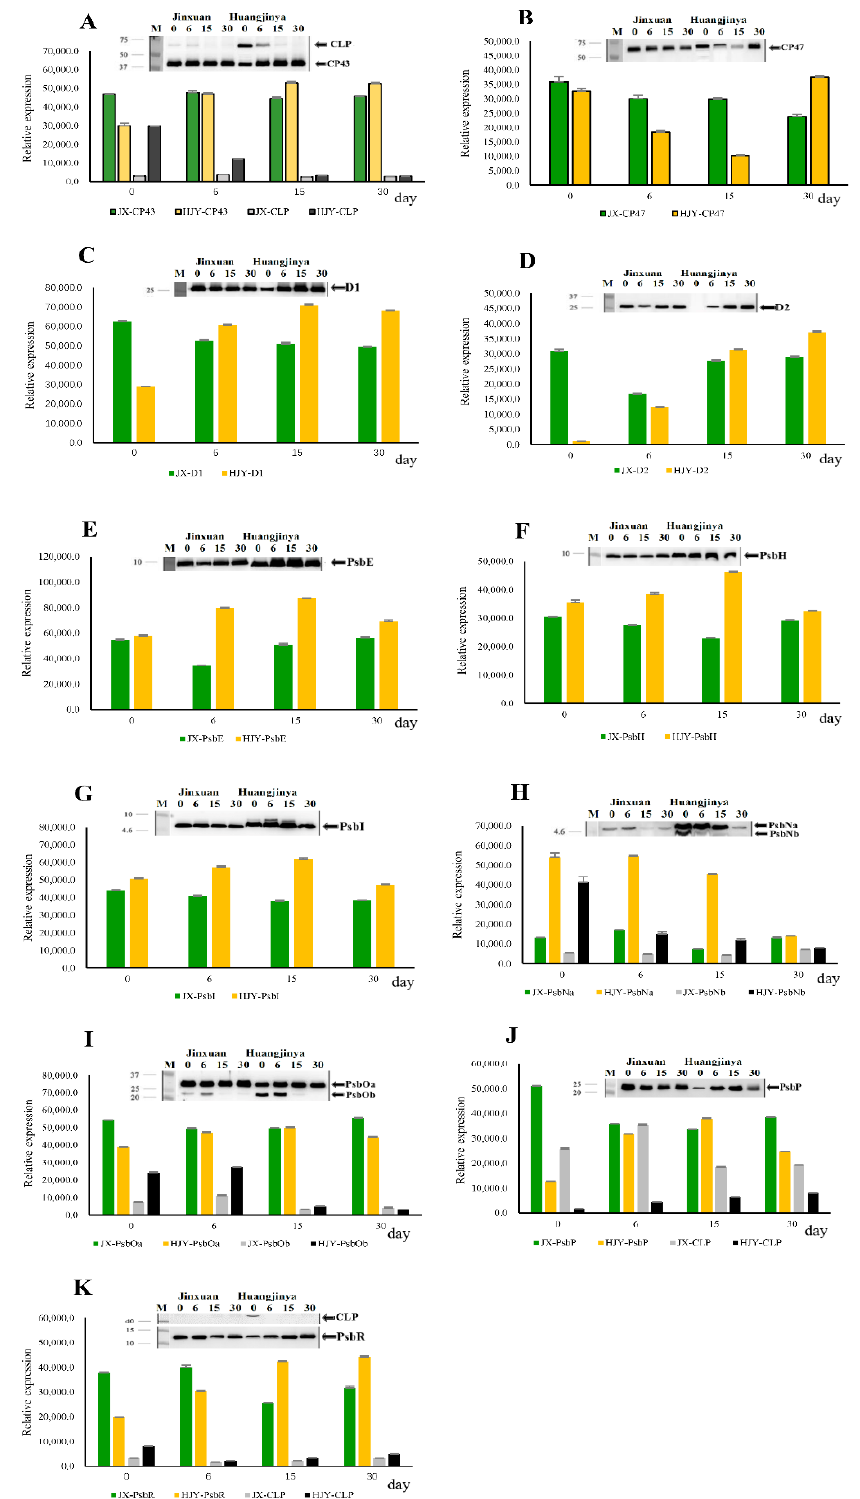
Figure 1. ( A – K ) Immunoblotting of PSII subunits during shading treatment. Thylakoids were extracted from the 4th leaf beneath apex bud on tea shoots, and 1 μ g of chlorophyll was used each lane. The blots were probed with specific antibodies: anti-CP43, anti-CP47, anti-D1, anti-D2, anti-PsbE, anti-PsbH, anti-PsbI, anti-PsbN, anti-PsbO, anti-PsbP, and anti-PsbR. CLP, crosslinking product. The data 0, 6, 15, and 30 refer to the days of shading treatment. The bars are expressed as mean ± standard deviation ( n = 3).